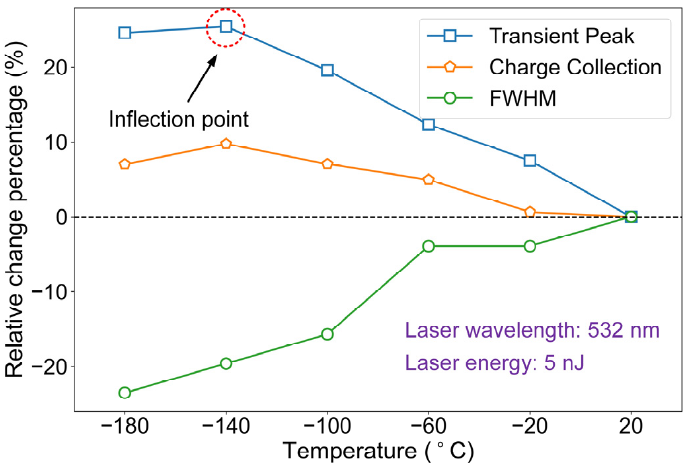
Figure 1. The relative percentage change (relative to 20 ℃ ) on collector’s transient peak, charge collection, and FWHM from pulsed laser testing.